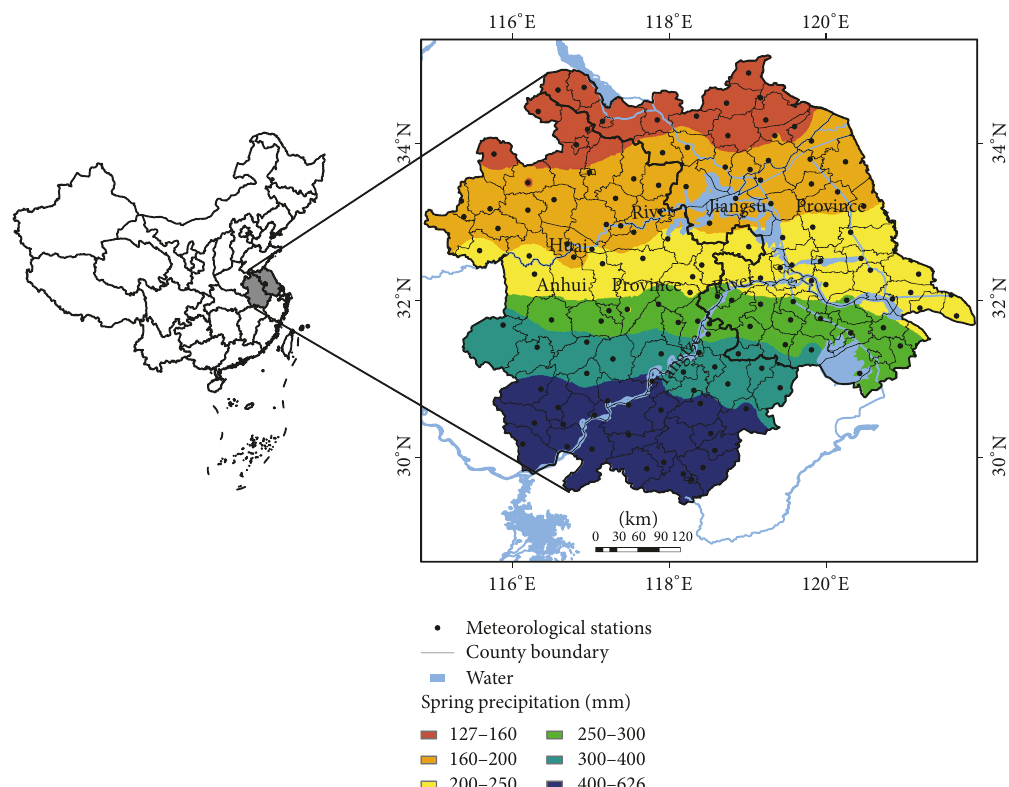
Figure 1: Map of the study